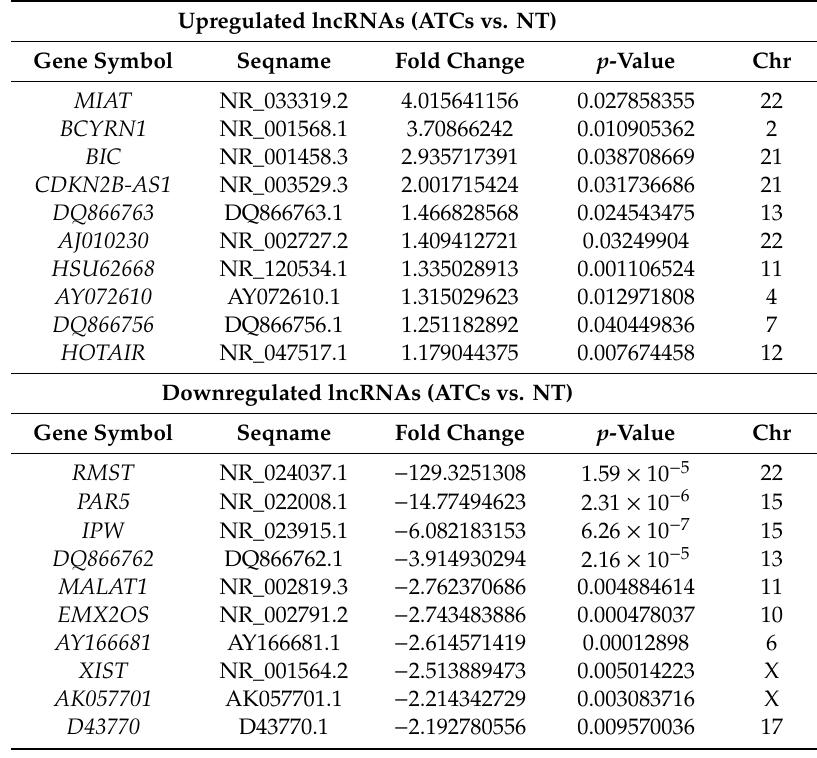
Table 1. Representative table of deregulated long non-coding RNAs (lncRNAs) in anaplastic thyroid carcinoma (ATC) with respect to normal thyroid (NT)